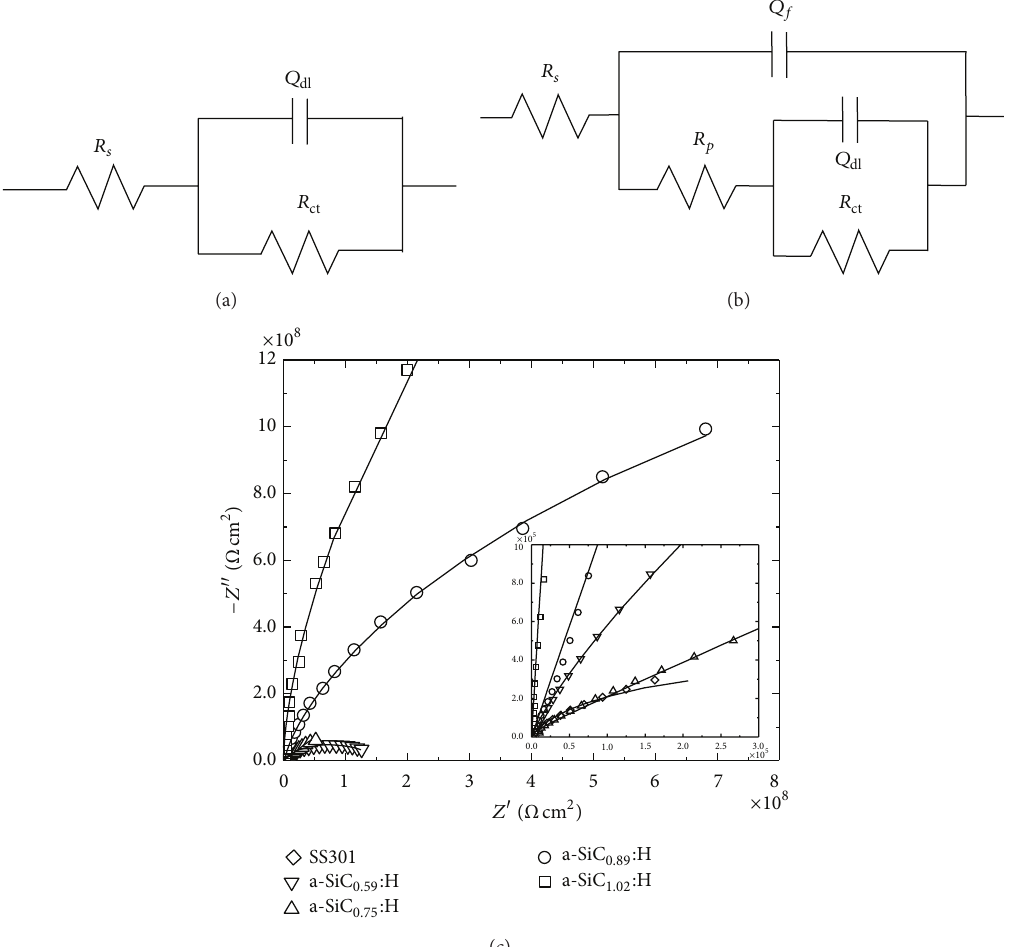
Figure 7: Equivalent circuits used for (a), (b) the EIS spectra fitting, and (c) Nyquist plot of EIS spectra for the a-SiC bare SS301 substrate.